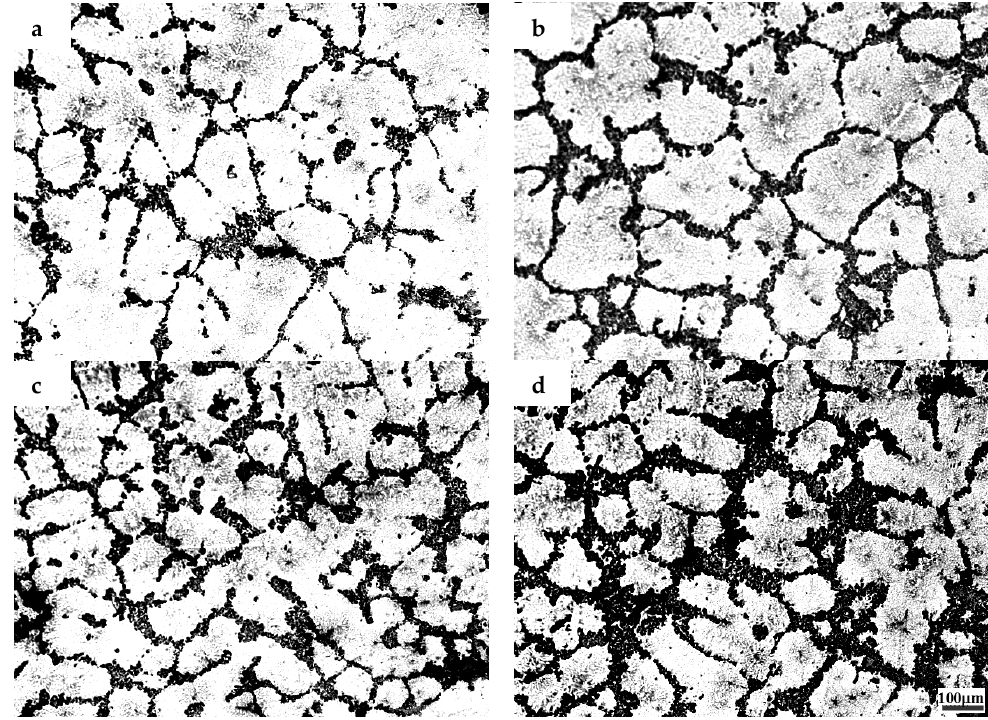
Figure 3. The microstructures of TiB 2 /7075 composites with cooling rate of 5 °C/min. ( a ) 3.0% TiB 2 /7075; ( b ) 4.5% TiB 2 /7075; ( c ) 6.0% TiB 2 /7075; ( d ) 9.0% TiB 2 /7075.